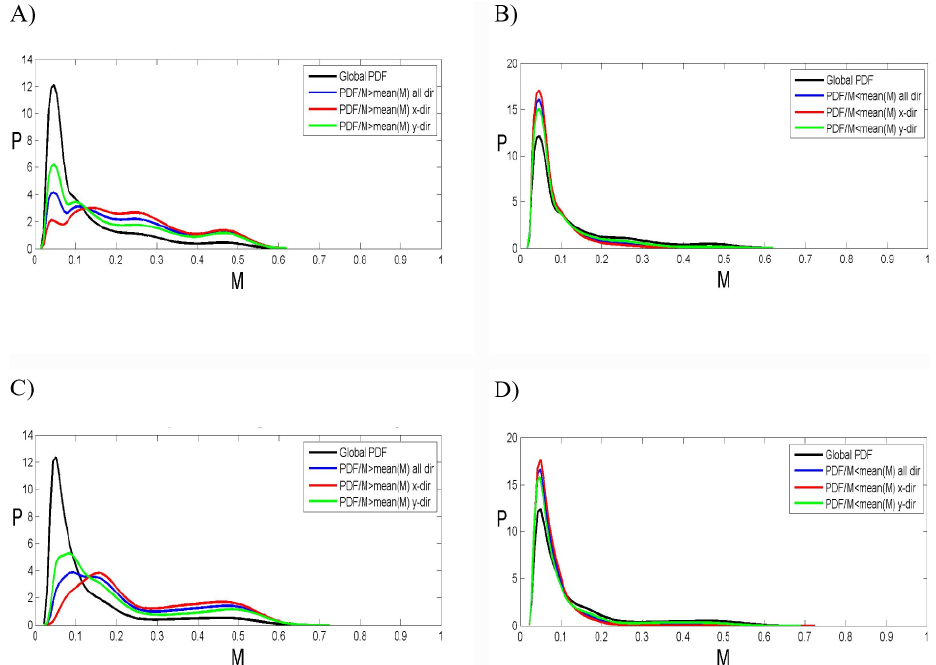
Fig. 9. Global and conditioned PDF analysis of the Somalia patterns. Panels (A/B) : natural, and (C/D) : simulated vegetation; panels (A/C) : density higher than global average, and (B/D) : density lower than global average. (A) PDFs of vegetation density for the natural pattern shown in Fig. 8a (as digitized in Fig. 8b): global PDF (black line) and PDFs of vegetation density conditioned on having a neighbor pixel with vegetation density higher than the global average for all directions (blue line), x-direction (red line) and y-direction (green line). (B) PDFs of vegetation density for the natural pattern shown in Fig. 8a (as digitized in Fig. 8b): global PDF (black line) and PDFs of vegetation density conditioned on having a neighbor pixel with vegetation density lower than the global average for all directions (blue line), x-direction (red line) and y-direction (green line). (C) PDFs of vegetation density for the simulated pattern shown in Fig. 8c: global PDF (black line) and PDFs of vegetation density conditioned on having a neighbor pixel with vegetation density higher than the global average for all directions (blue line), x-direction (red line) and y-direction (green line). (D) PDFs of vegetation density for the simulated pattern shown in Fig. 8a: global PDF (black line) and PDFs of vegetation density conditioned on having a neighbor pixel with vegetation density lower than the global average for all directions (blue line), x-direction (red line) and y-direction (green line).